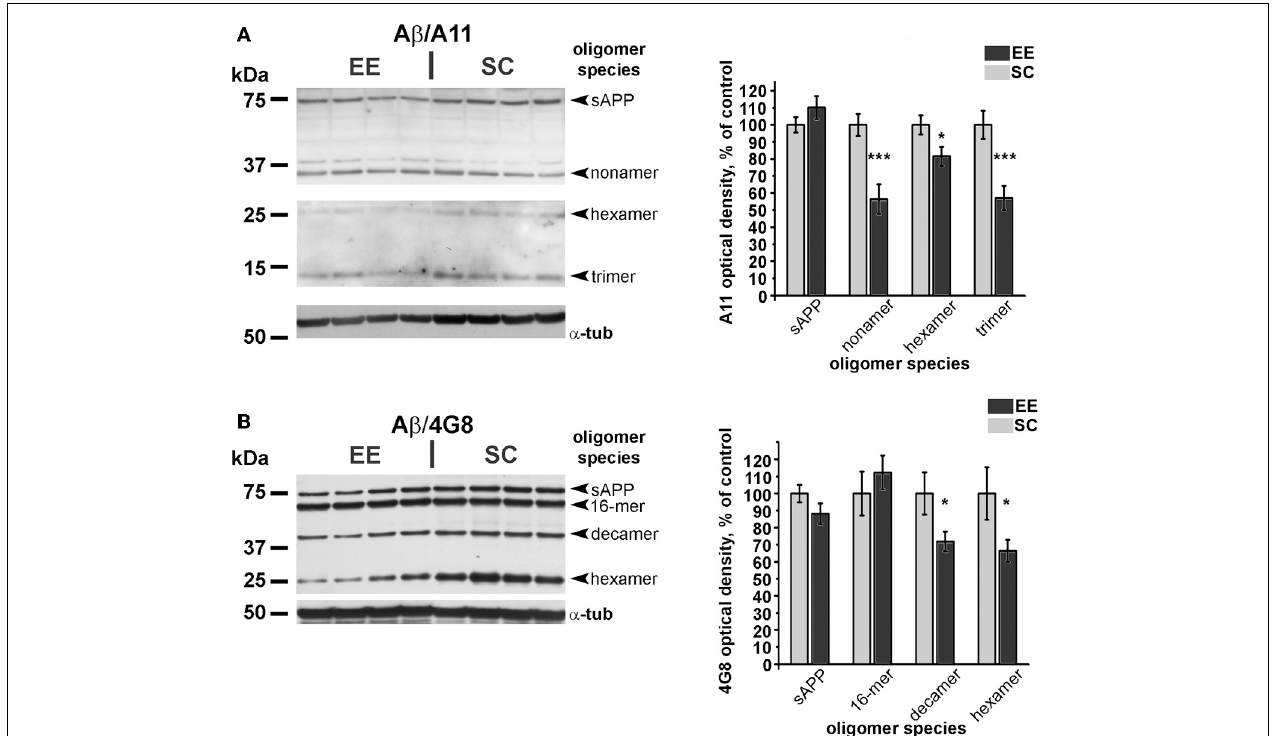
oligomers probed with the 4G8 monoclonal antibody. In both cases, optical density of autoradiographic bands mice was normalized as percentage of the